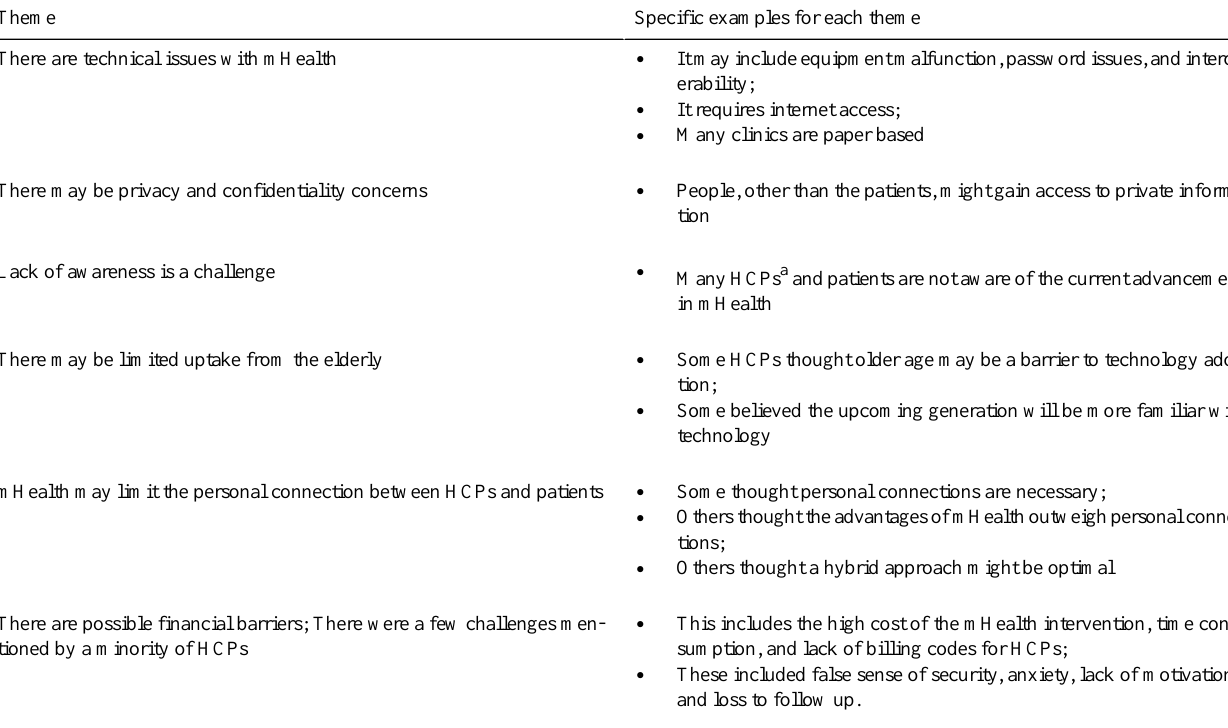
Table 3. Themes with specific examples regarding the barriers of mobile health (mHealth)